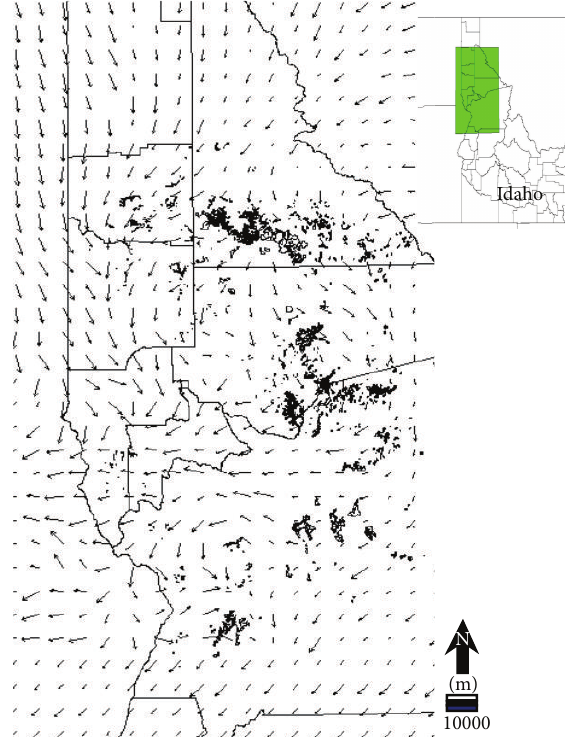
Figure 2: July wind plot indicating direction and force in north central Idaho. 1995 balsam woolly adelgid infestations are in black.